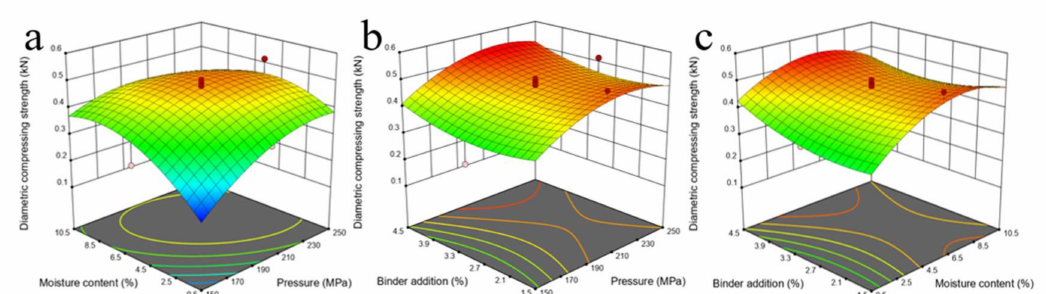
Figure 7. Three-dimensional surface plot and interaction of process variables on diametric com- pressing strength. ( a ) Effect of pressure and moisture content at binder addition of 3%; ( b ) Effect of pressure and binder addition at moisture content of 5.5%; ( c ) Effect of moisture content and binder addition at pressure of 200 MPa.